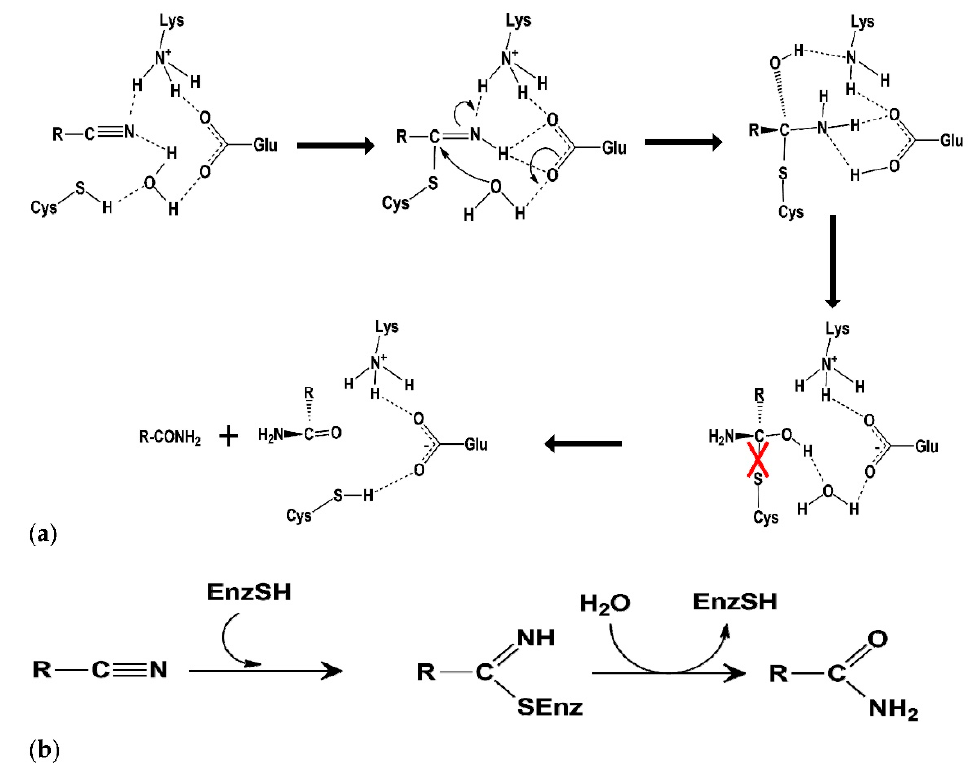
Figure 1. ( a ) Putative catalytic mechanism of cyanide hydratase, and ( b ) reaction catalyzed cyanide degradation.